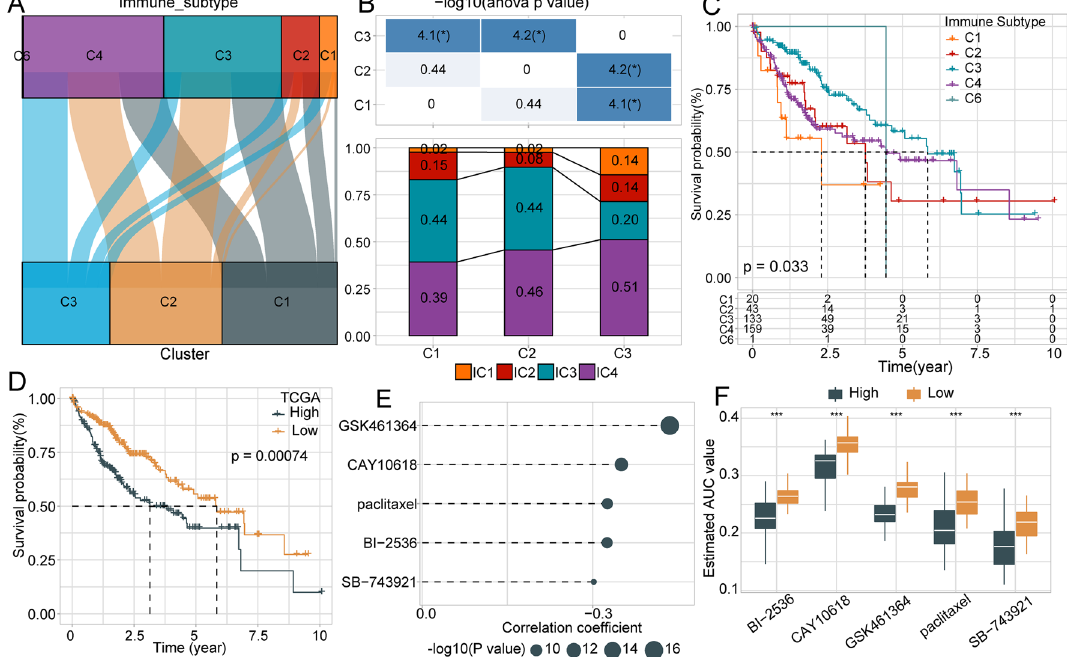
Figure 8. Comparison between existing subtypes and our molecular subtypes and drug sensitivity analysis. ( A ) Sanki diagram comparing our molecular subtypes and existing molecular subtypes. ( B ) Comparison immune subtype distributions across our three defined molecular subtypes. ( C ) Survival curves associated with existing immune subtypes. ( D ) Kaplan–Meier (KM) curves for high- and low-risk groups in the TCGA cohort. ( E ) Drug sensitivity to chemotherapy in patients from the TCGA dataset based on the CTRP2.0 database. ( F ) Drug sensitivity to chemotherapy in patients from the TCGA dataset based on the PRISM